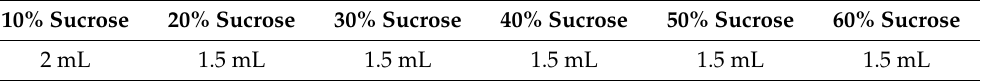
Table 2. Composition of the sucrose gradient which was used for ZIKV